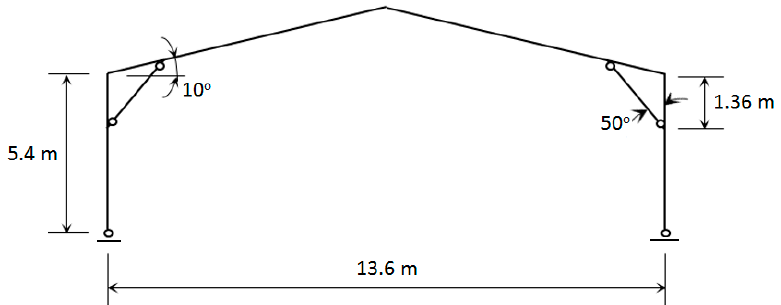
Figure 1. Geometry of CFS Benchmark Frame with knee brace joints.